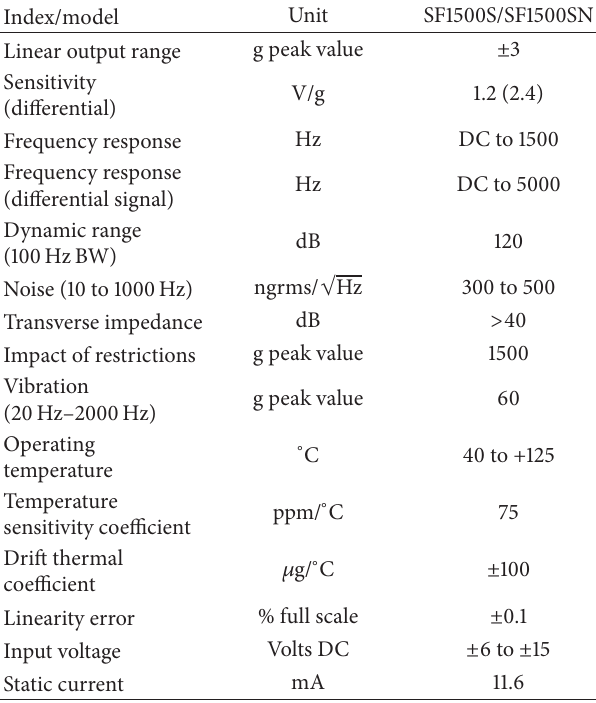
Table 4: Technical data of microseism sensor.